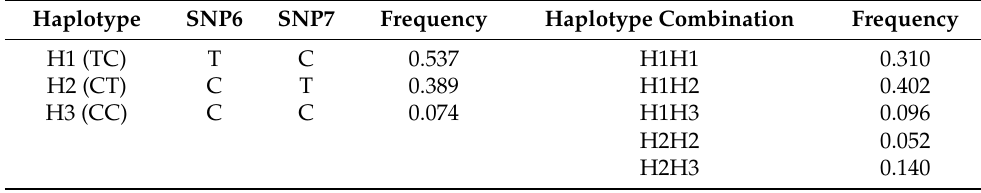
Figure 6. Linkage disequilibrium plot ( r 2 ) and haplotype blocks for SNPs of the IGF1 gene in Hulun Buir sheep. The values within boxes are pairwise SNP correlations ( r 2 ) and light red boxes represent 79 very weak LD ( r 2 < 0.001).